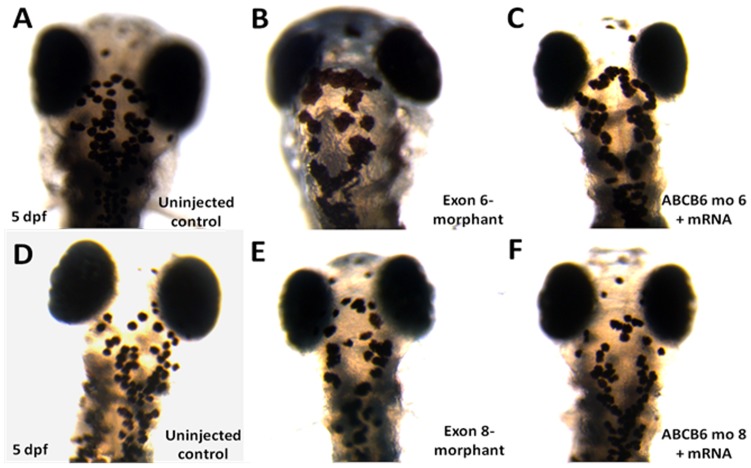
Number of mature melanocytes in the head region in the morphants and rescued embryos (5 dpf).Immobilized embryos were dorsally oriented and the number of mature melanocytes was counted in the defined region of the head. Reduction in melanocyte number was observed in both exon 6- and exon 8-morphants (B and E). Co-injection of wildtype hABCB6 mRNA transcript significantly rescued the loss of melanocyte phenotype by increasing the number of mature melanocytes (C and F).